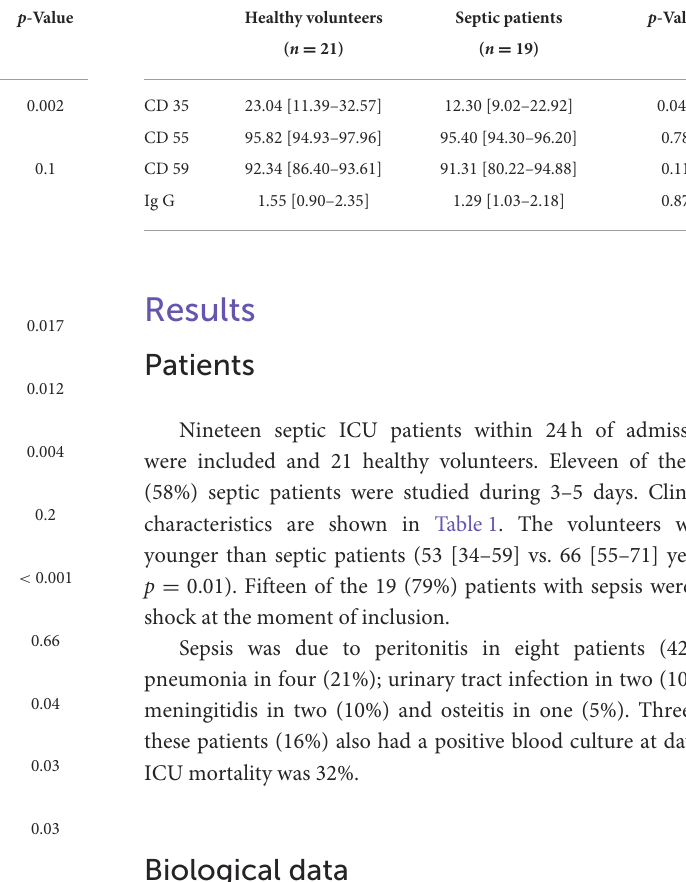
TABLE 1 Subject demographics, biological characteristics, and outcomes.